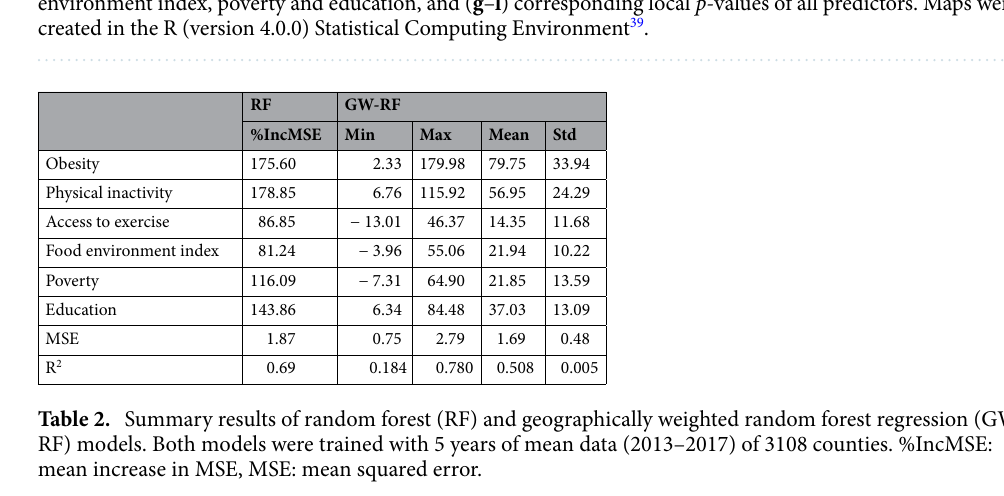
ficients for access to exercise (Fig. 5c,i) and food environment index (Fig. 5d,j). A small number of the counties showed a significant positive coefficient for education (Fig. 5f,l). Geographically weighted random forest regression (GW-RF). The GW-RF model showed lower MSE values than that of global RF (Table 2). The local pseudo-R 2 ranged from 0.18 to 0.78, with a mean value of 0.50. The local GW-RF models are more robust (pseudo-R 2 > 0.6) in 28% of counties in parts of the West and